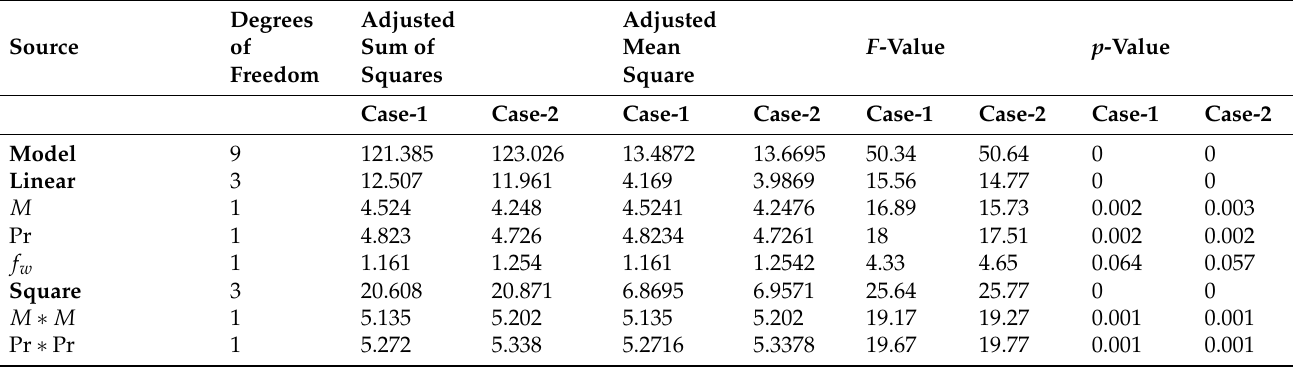
Table 5. For Nus , the variance was